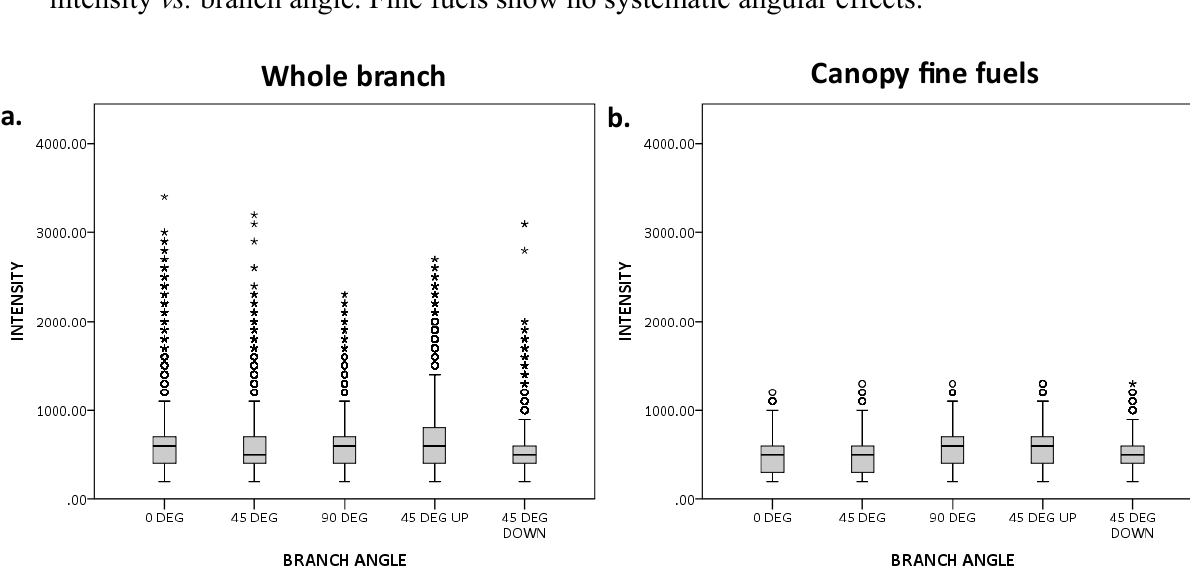
Figure 8. Box-and-whisker plots for whole-branch and canopy fine fuel intensities for lumped branch samples at 25 m across multiple angles. (a) Whole branch intensity vs. branch angle. Observed variations are likely due to differences in biomass shadowing based on the scan angle combined with instrument sensitivity. (b) Canopy fine fuel intensity vs. branch angle. Fine fuels show no systematic angular